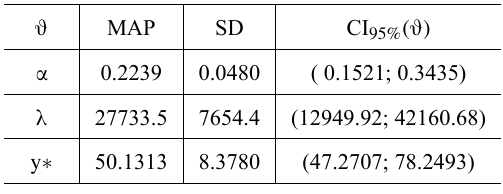
MAPs, SDs and 95% CIs for α , λ and y ∗ related to the WH distribution.